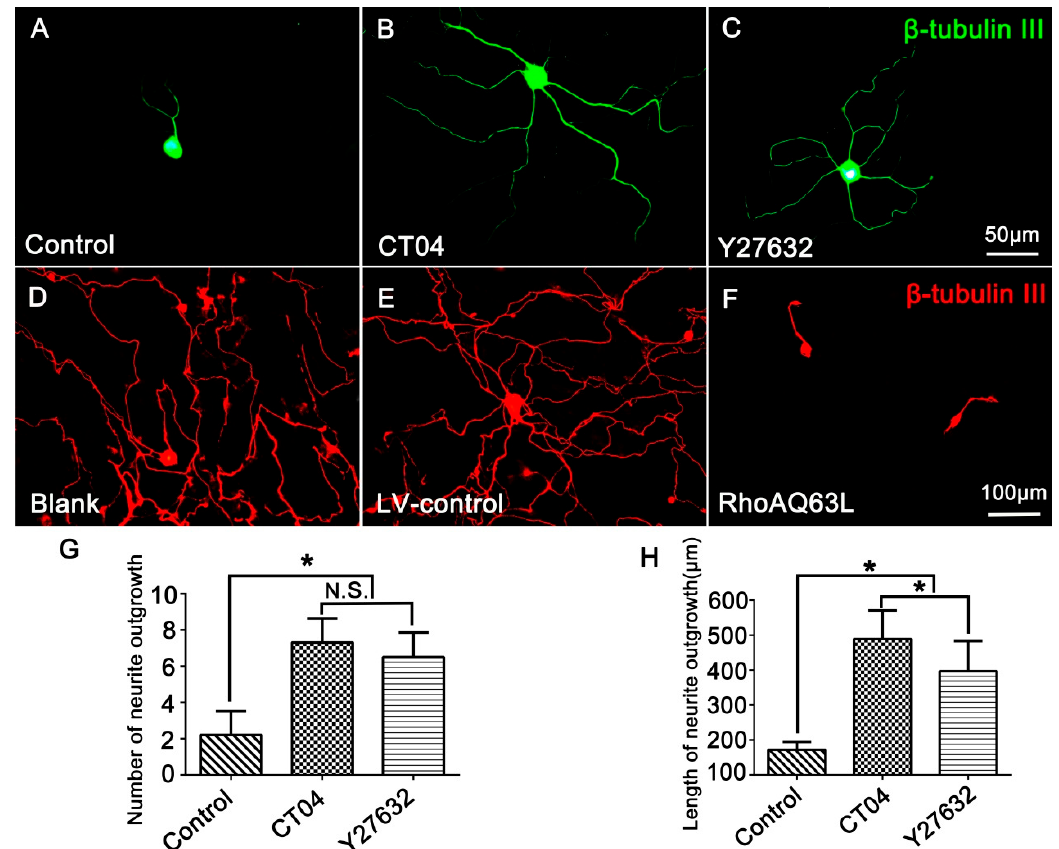
Figure 1. The RhoA signaling pathway negatively modulates neurite outgrowth in DRG neurons. ( A – C ) Representative images of β -tubulin III-positive neurons (green) in different drug treatment groups. Quantitative analyses of the number ( G ) and length ( H ) of the neurites of each neuron in different groups. Compared with the control group, CT04 and Y27632 treatments remarkably increased the number and length of the neurites. ( D – F ) Representative immunofluorescence staining for β -tubulin III (red) showed that compared with the Blank and LV-control groups, the overexpression of constitutively activated RhoA (RhoAQ63L transfection) dramatically reduced neurite outgrowth in the DRG neurons. Data are presented as the mean ± standard error of the mean (SEM) (*indicates p < 0.05, meaning a statistically significant difference, while N.S. indicates nonsignificance).